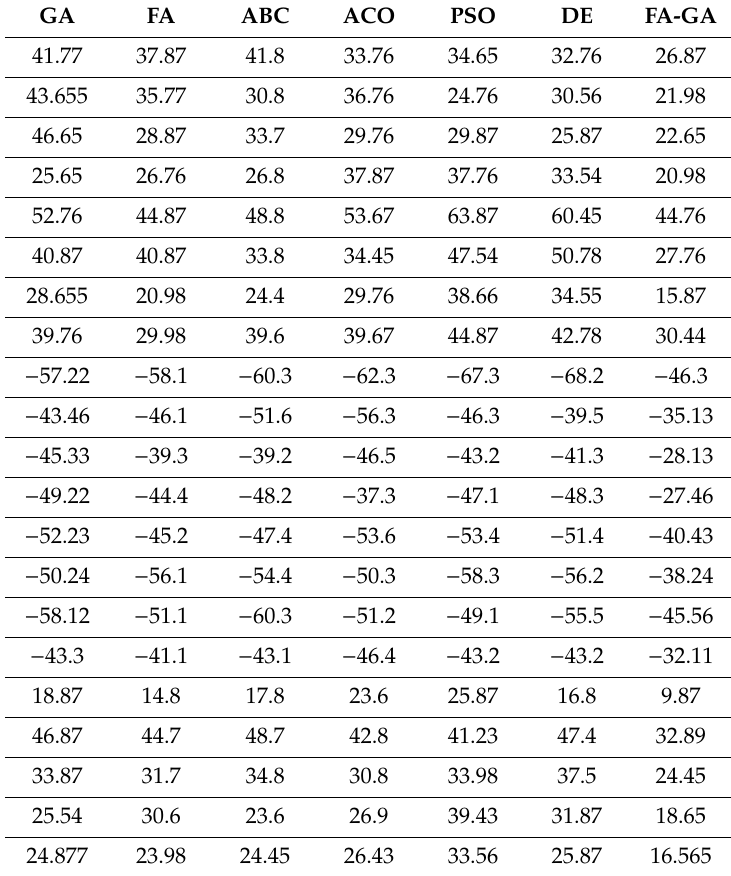
Table 5. The illumination error di ff erences based on the considered